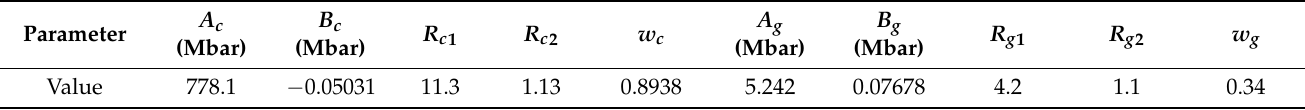
Table 3. The deterministic parameter values of Composition B in the JWL equation of state.